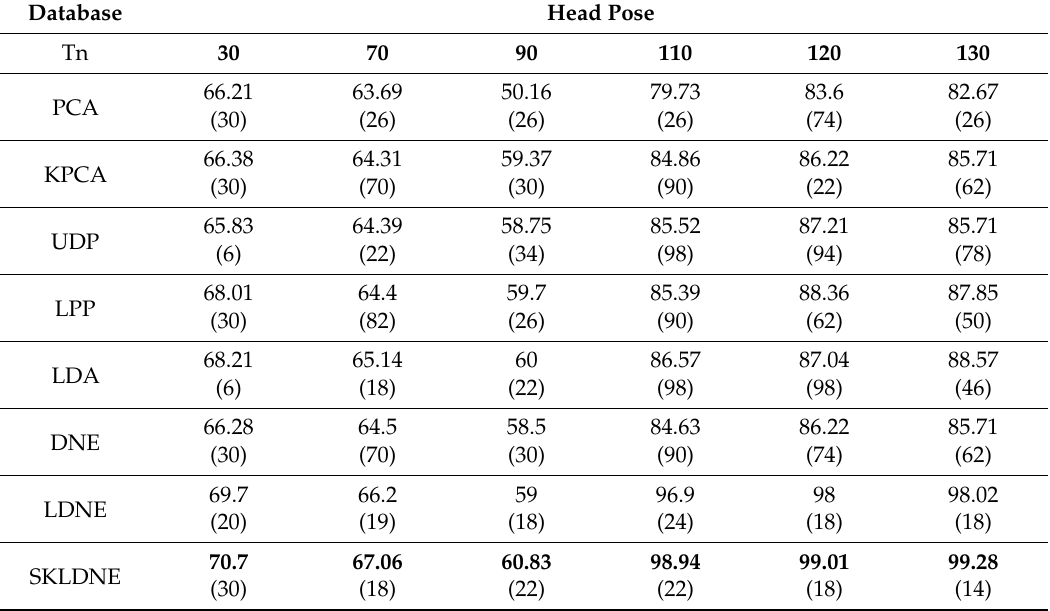
Table 4. Maximum recognition accuracies (in percentage terms) of SKLDNE and other methods for the different number of training and testing images on Head Pose database and corresponding dimensions (shown in parentheses).